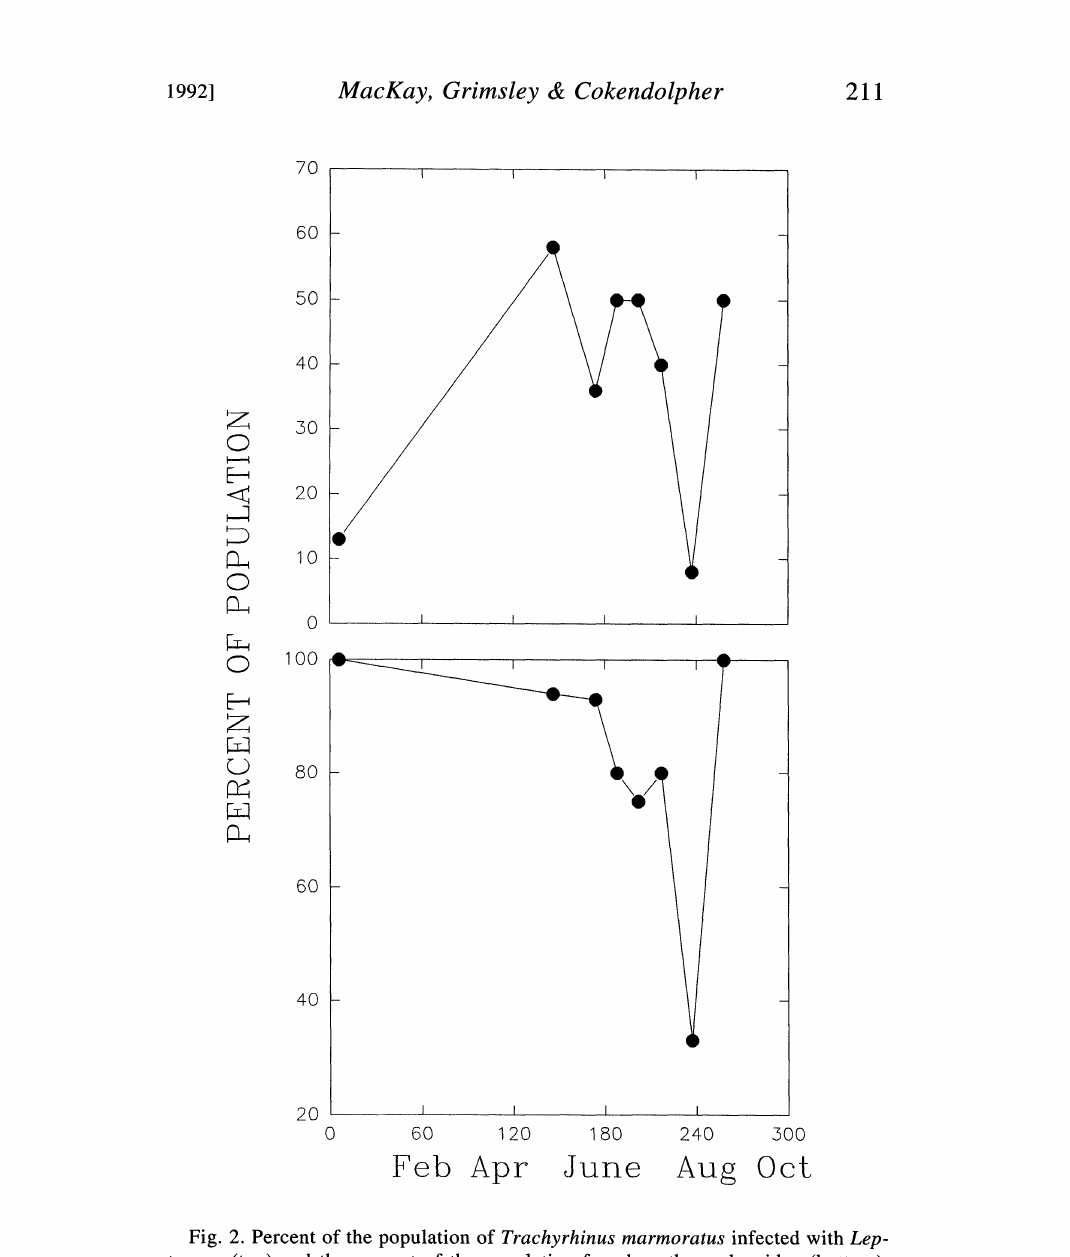
Fig. 2. Percent of the population of Trachyrhinus marmoratus infected with Lep- tus sp. (top) and the percent of the population found on the rocky ridge (bottom). The percent of the population found in rocky areas on day 240 consists almost entirely of juveniles; before day 240 it consisted almost exclusively of